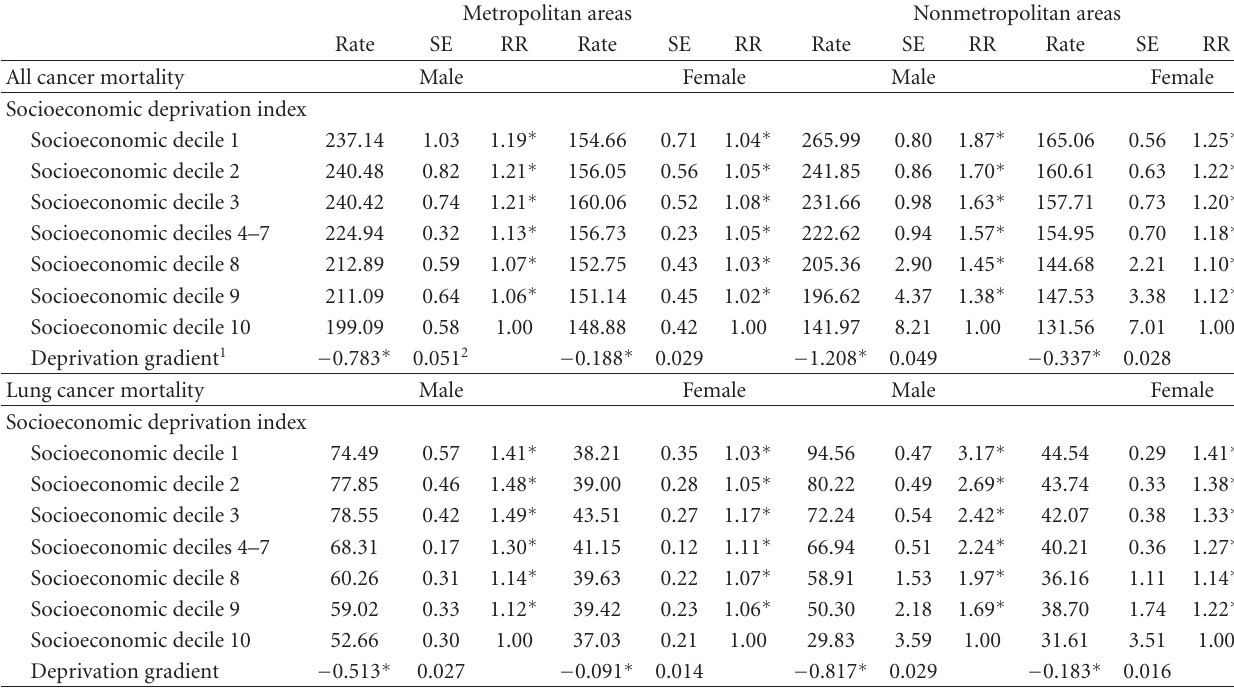
Table 4: Socioeconomic disparities in all-cancer and lung cancer mortality rates per 100,000 population and relative risks (RR) and gradients in mortality within metropolitan and nonmetropolitan areas of the United States,